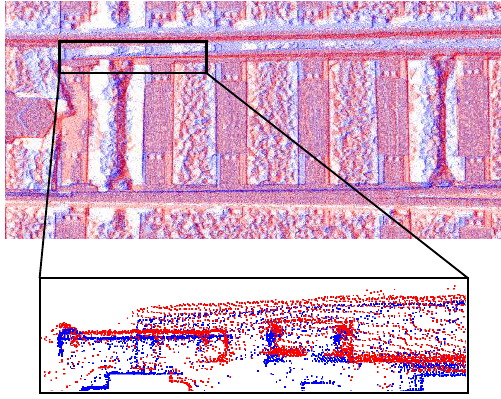
Figure 10. Point blade captured by Two MLSs directly above the